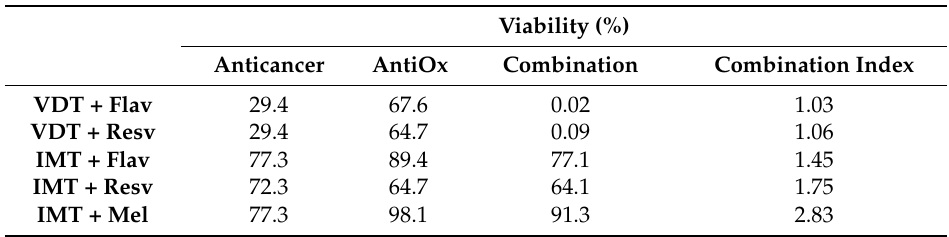
Table 8. Viability of NTS (%) following exposure to anticancer drugs, antioxidants, drug combinations, and combination